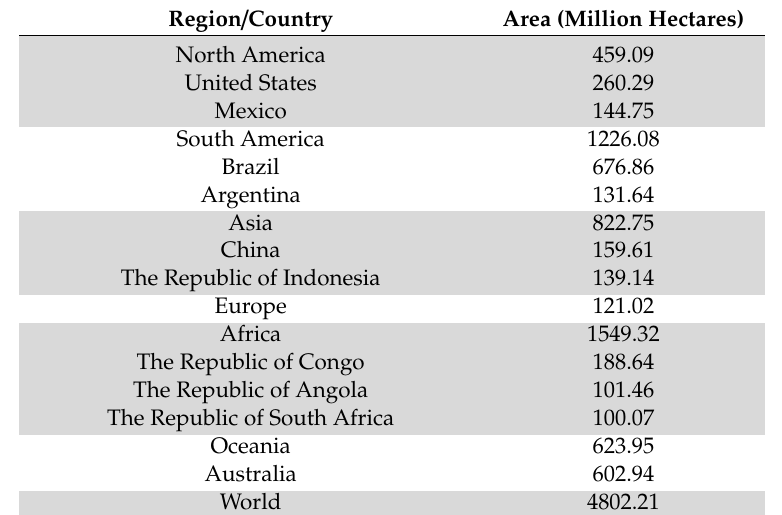
Table 2. Marginal lands suitable for sweet sorghum within each major world region and the top ten countries.